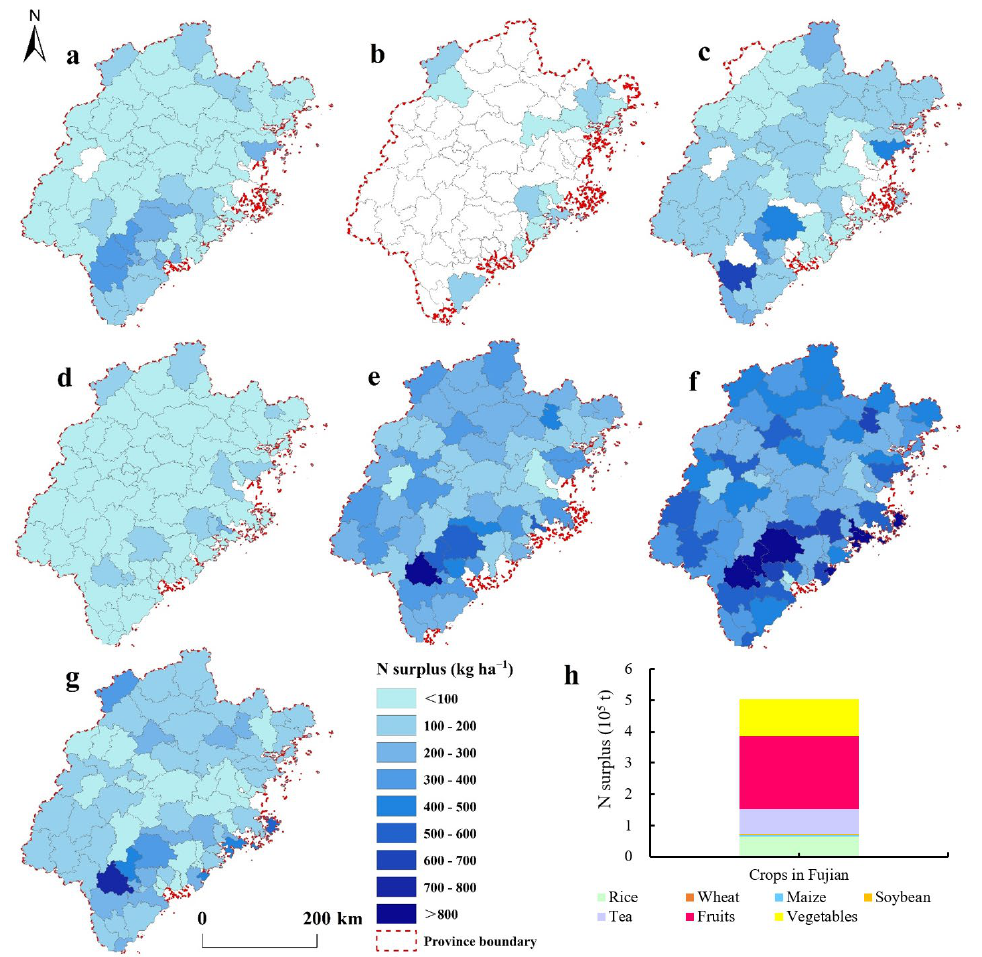
Figure 6. The spatial patterns of N surplus of various crops including rice ( a ), wheat ( b ), maize ( c ), soybeans ( d ), tea ( e ), fruits ( f ), and vegetables ( g ) at the county level in Fujian Province, as well as the N surplus amounts of various crops in Fujian Province ( h ).